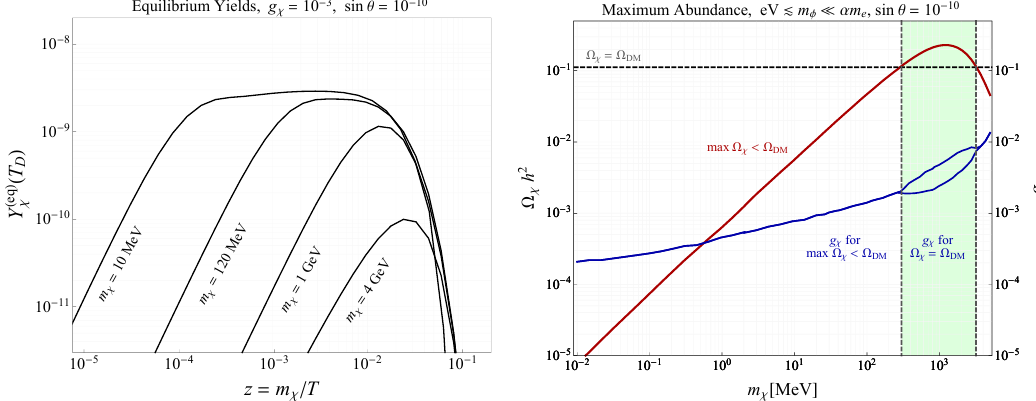
Figure 3 . Left: comoving equilibrium yields Y eq = n eq ( T D ) =s ( T ) plotted against the dimensionless (cid:31) (cid:31) time variable z = m (cid:31) =T for a various m (cid:31) . Note that the dark temperature is determined primarily by the (cid:30) energy density, which is independent of m (cid:31) , so each mass point has comparable T D during production; thus, su(cid:14)ciently large masses are highly Boltzmann suppressed. Right: Maximum DM abundance for a range of m (cid:31) with (cid:12)xed sin (cid:18) = 10 (cid:0) 10 , which is still viable, but near the Red Giant exclusion bound (see left panel of (cid:12)gure 5). Below m (cid:31) . 200 MeV, the blue curve represents the coupling for which the maximum abundance (red curve) can be achieved; larger values merely annihilate away more of the DM as the number density tracks the equilibrium distributions (left) out to larger values of z (see (cid:12)gure 4, left). In the green band between the dashed vertical lines, max (cid:10) (cid:31) h 2 > 0 : 12 so it is possible to achieve the full abundance for two choices of couplings, as shown for a representative mass point in (cid:12)gure